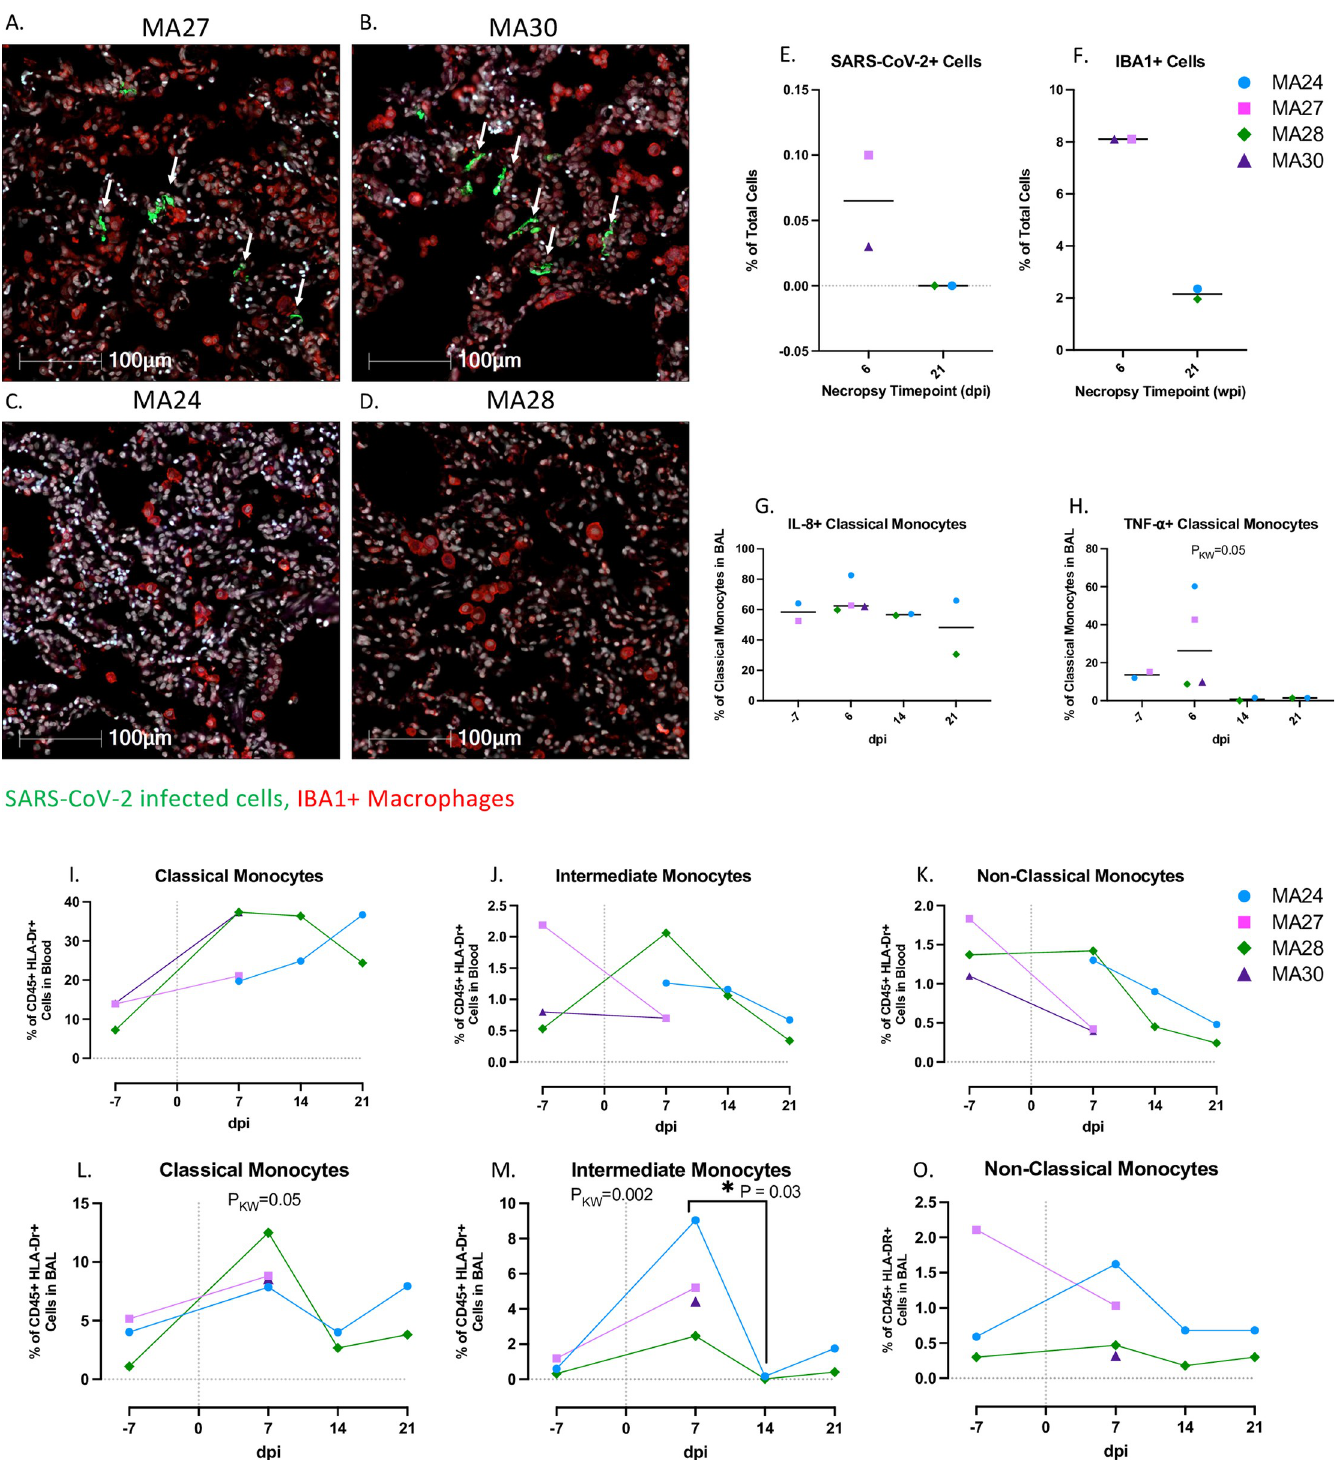
Fig 4. Pulmonary SARS-CoV-2 infection and macrophage/monocytes in the lung and blood. A-D. SARS-CoV-2 infection and macrophage infiltration in the lungs of pigtail macaques at 6- (A and B) and 21- days post infection (dpi, C and D). DAPI = White, Green = SARS-CoV-2, Red = IBA1, Blue = Autofluorescence. E and F. Percentage of SARS-CoV-2 infected cells (E) and IBA1+ macrophages (F) in the lung at necropsy. Bars represent median. G and H. Frequency of IL-8 (G) and TNF- α (H) expressing classical monocytes (CD45+ HLA-DR+ CD14- CD16+) in BAL. I-O. Frequencies of Classical (I and L) intermediate (CD45+ HLA-DR+ CD14+ CD16+) (J and M), and non-classical monocytes (CD45+ HLA-DR+ CD14- CD16+) (K and O) in the blood and BAL before and after SARS-CoV-2 infection. Day 0 = day of